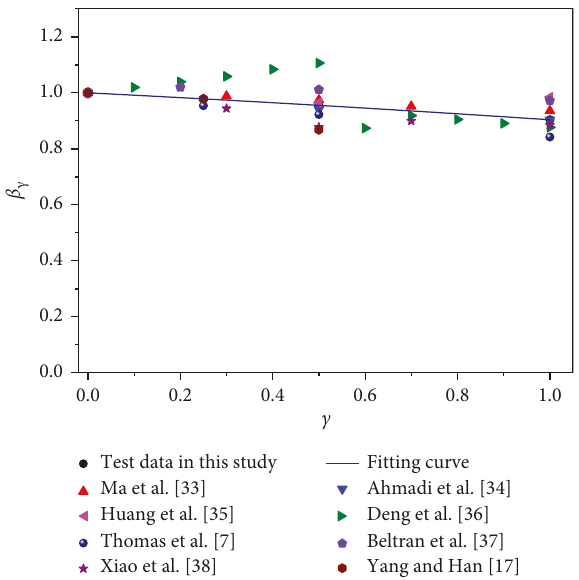
Figure 9: Relationship between β